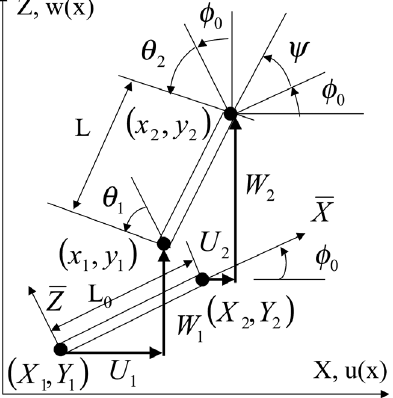
Fig. 1. Two-nodes nonlinear fi nite element based on fi nite strain beam